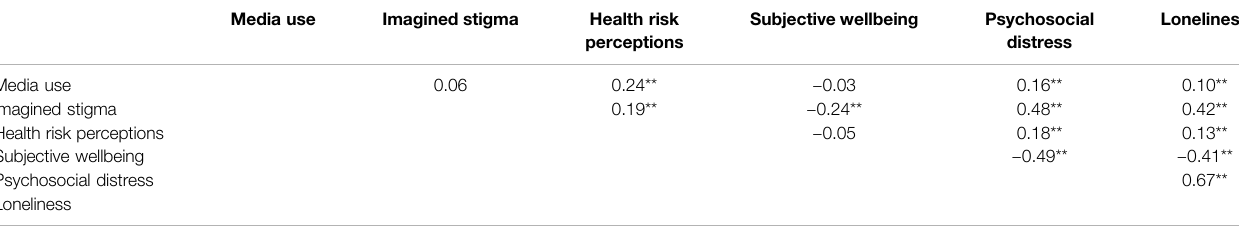
TABLE 2 | Correlations among main variables.